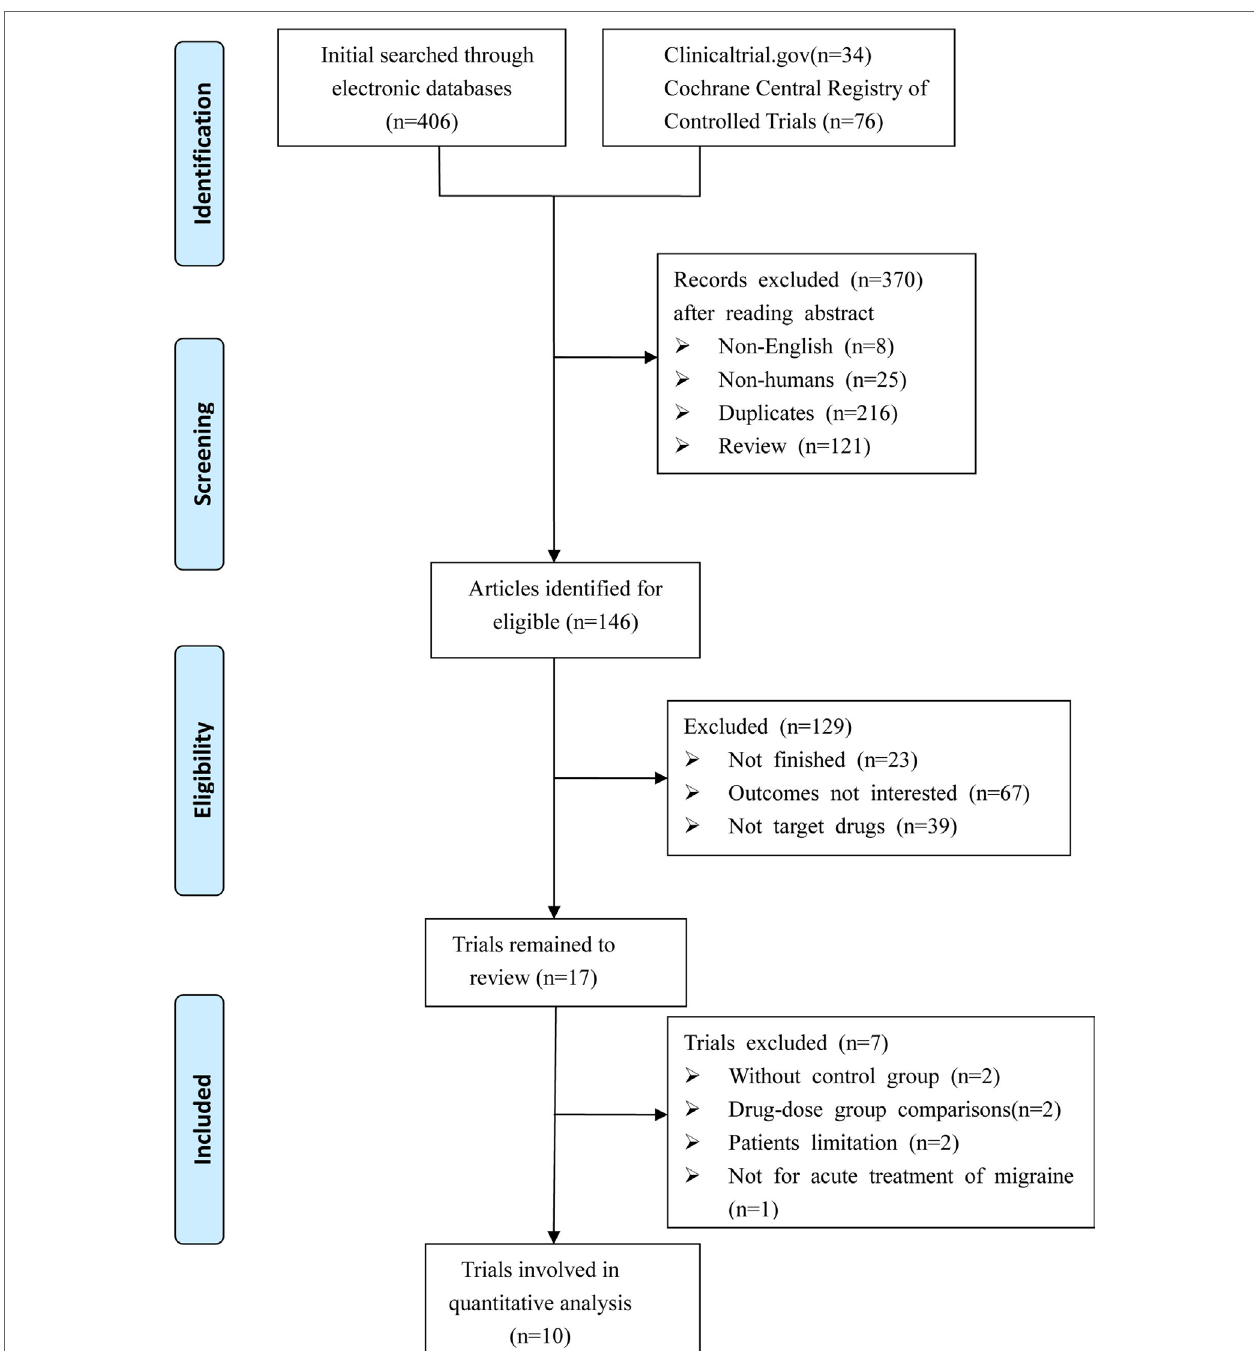
FIGURE 1 | Diagram of eligible studies selection